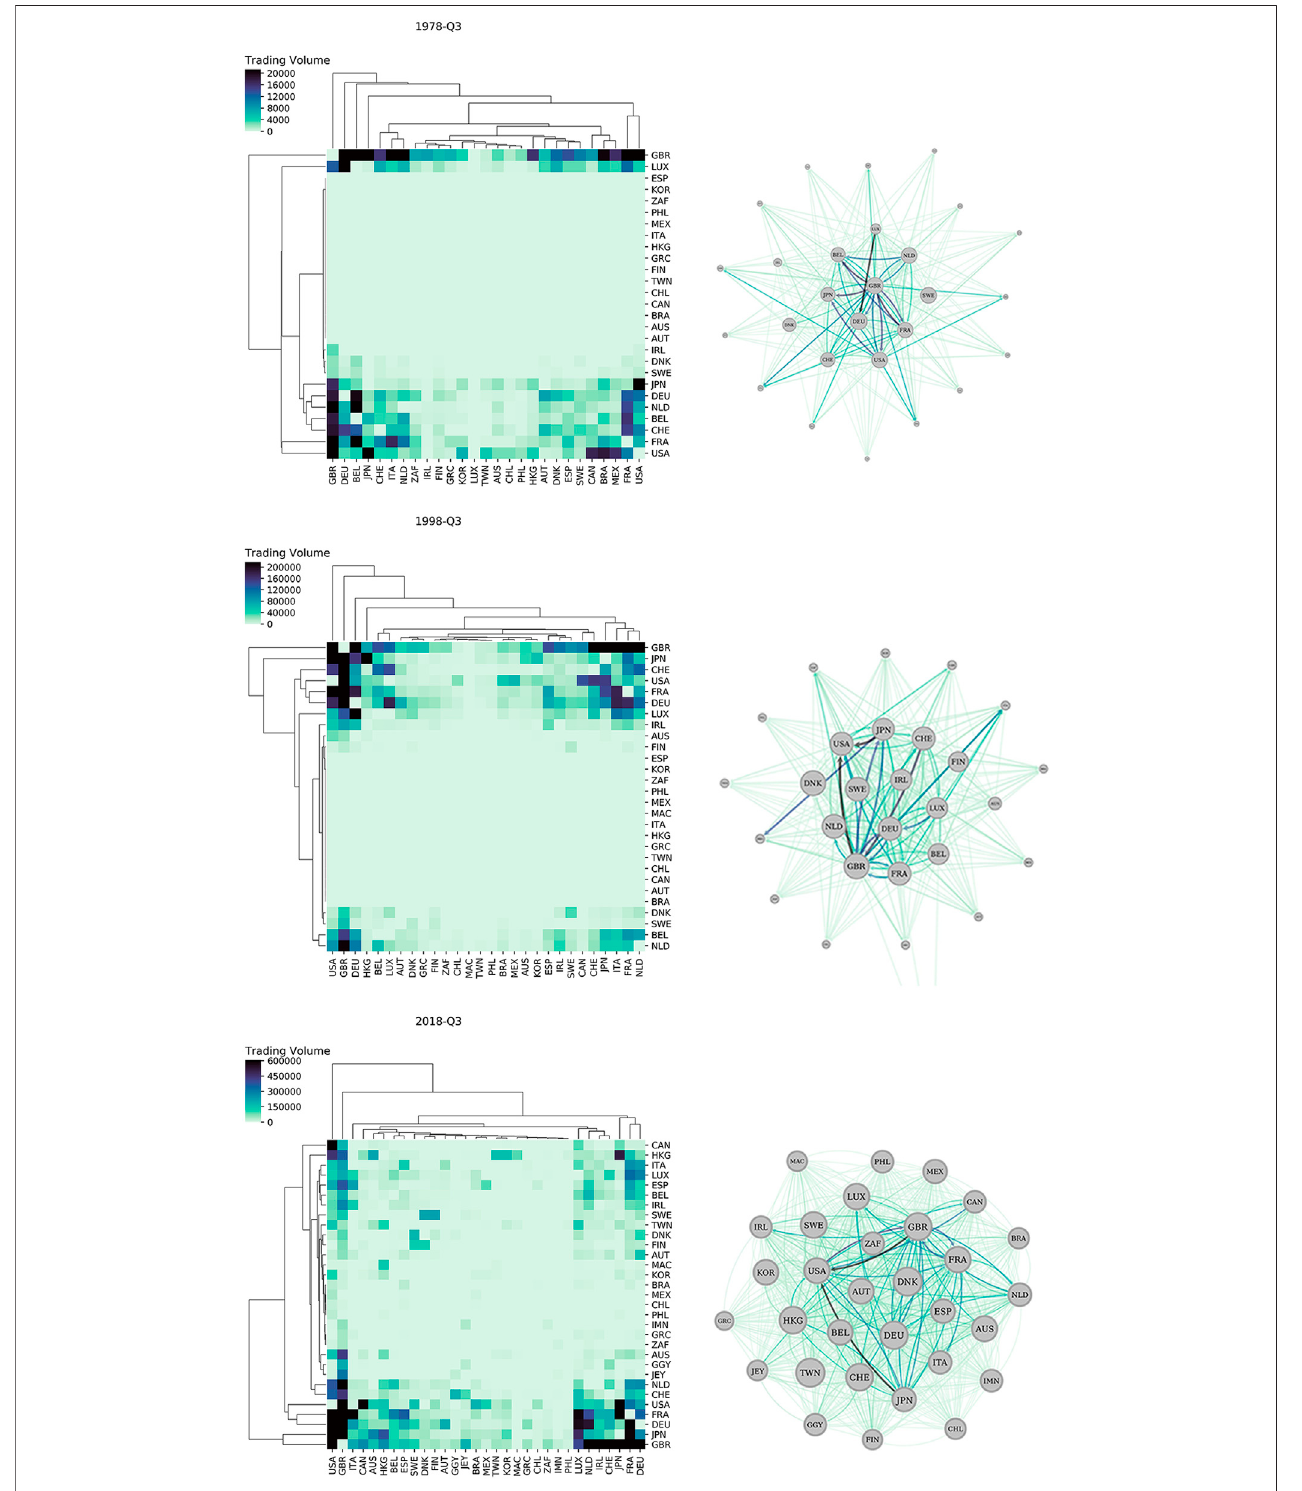
FIGURE 1 | The evolution of the global banking network is demonstrated for three snapshots of 1978-Q3, 1998-Q3, and 2018-Q3. Left) shows the dendrogram structure of communities for trading weighted matrices. Right) the network topology is graphed. The size of each node represents the degree.